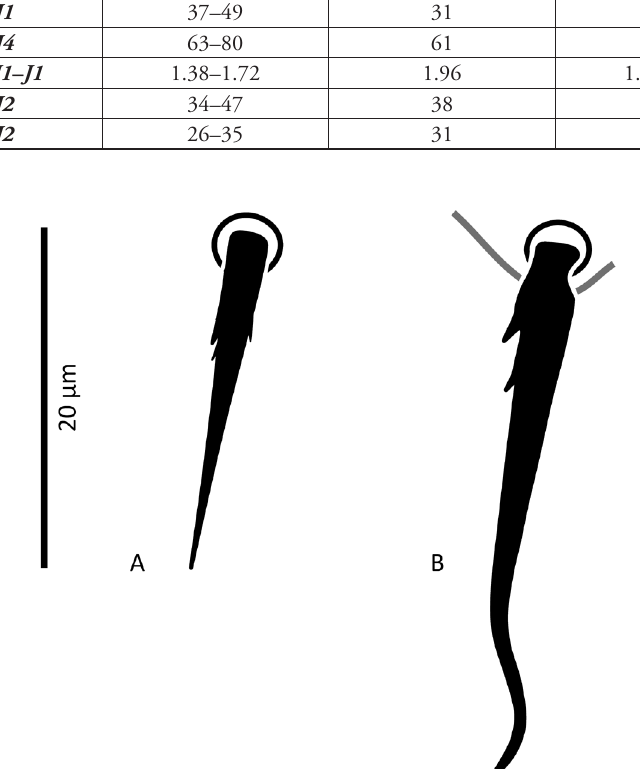
Figure 17. Zygoseius lindquisti sp. n., female, A seta J5 B seta J4 .